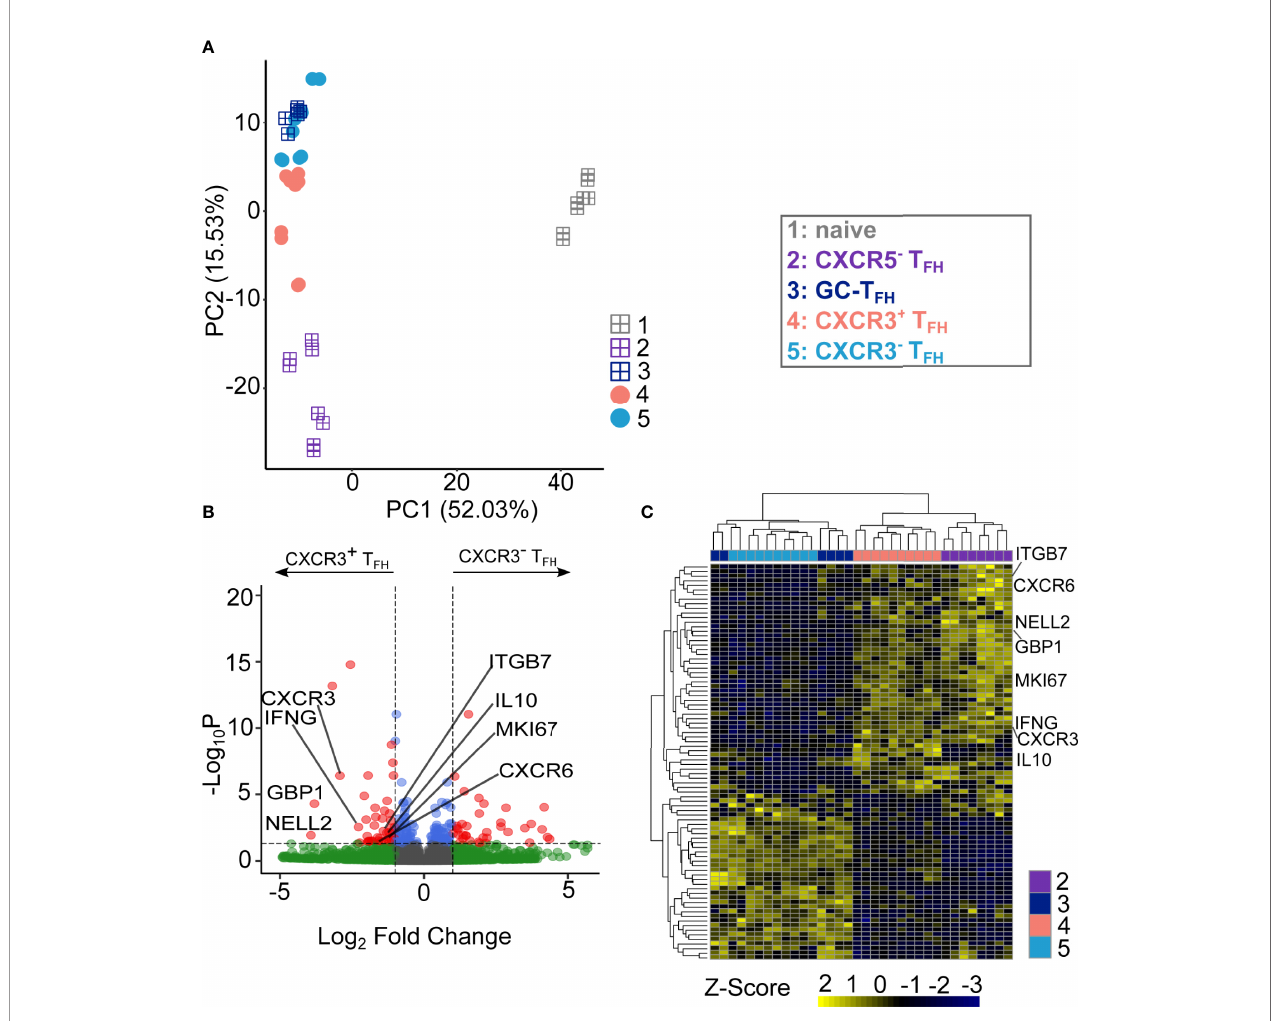
FIGURE 2 | CXCR3 + T FH population and CXCR3 - T FH are functionally distinct. (A) PCA visualization of the transcriptional data of different T cell subsets. Square-plus dots represent the well-established T cell populations while circle dots represent the T FH subsets. Numbers on the axis represents the proportion of variance. (B) Volcano plot of DEGs between CXCR3 + T FH and CXCR3 - T FH . Highlighted genes are upregulated genes of interest within CXCR3 + T FH population. DEGs were identi fi ed as log2(Fold Change) larger than 1 and adjusted P value (Benjamini-Hochberg adjustment) < 0.05. (C) Heatmap showing the expressing of